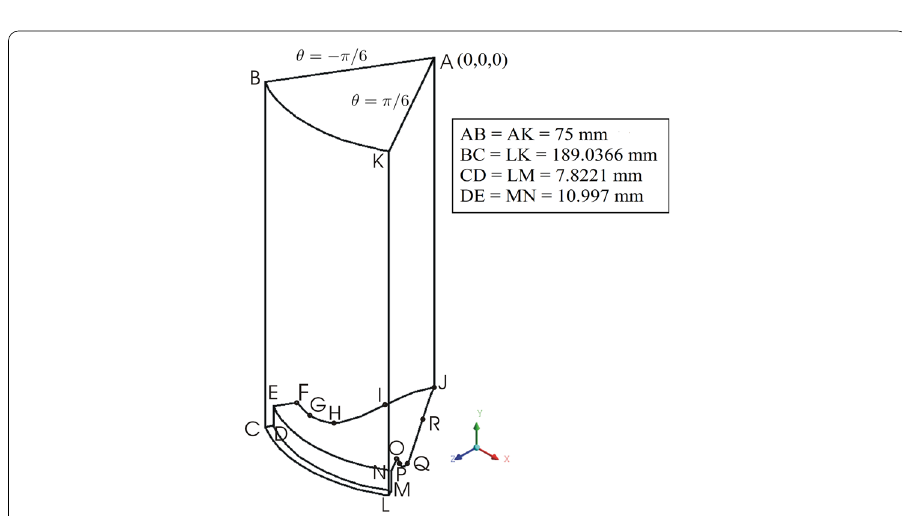
and so the intake and exhaust ports and the corresponding valves are not included in the computational domain. In the current study, this period expands from 570 ◦ CA to 833 ◦ CA. The in-cylinder flow is initialized by inducing a swirl of intensity 1.3 at the